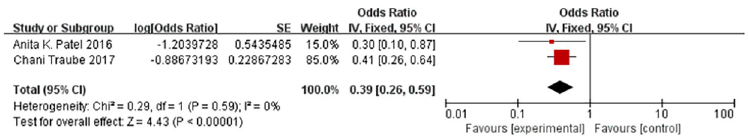
Fig 7. Forest plot for ages between 0 to 2 and 5 to 13. We conducted meta-analysis for 2 studies using a random effects model. We used ORs and 95% CIs to represent the results.